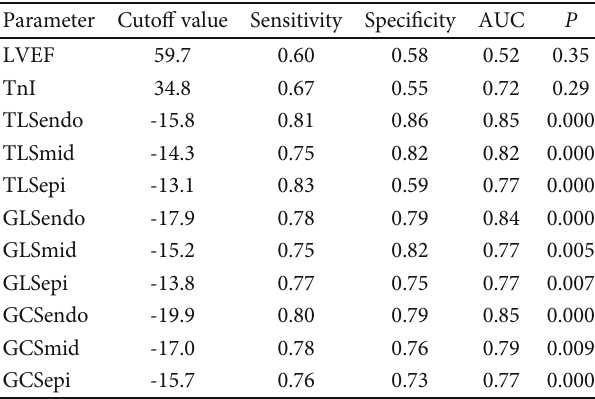
Table 4: Comparison of ROC curves for each parameter identifying patients with or without signi fi cant